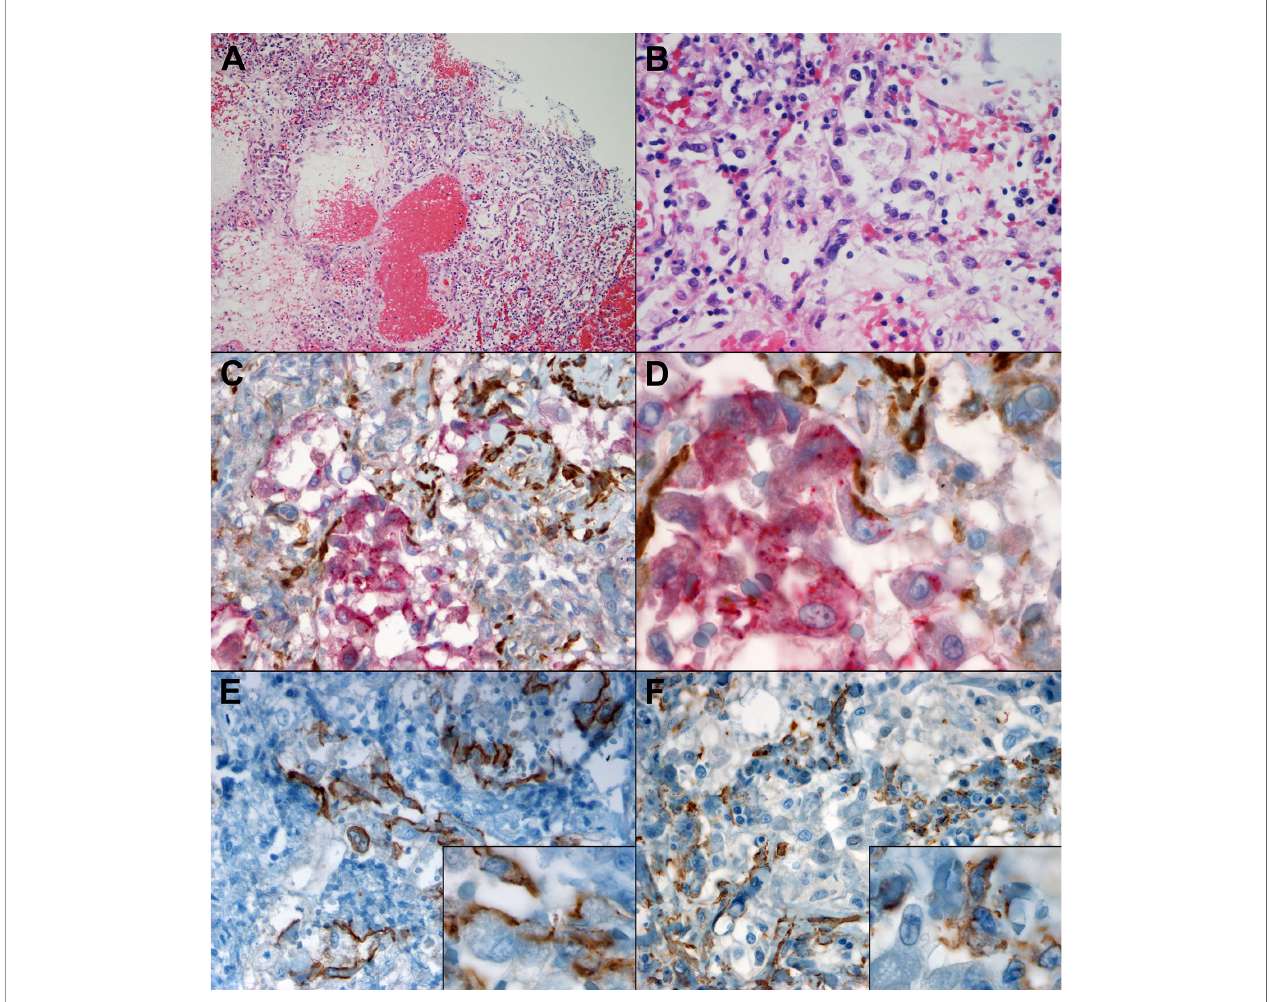
FIGURE 2 | Morphological and immunohistochemical clues of EMT in lung tissue of patients which died of COVID-19, with DAD in proliferative phase. (A) At low power, oedema, vascular congestion, hemorrhage, and in fl ammatory in fi ltrates are visible (H&E, 10x). (B) At higher magni fi cation, hyperplastic pneumocytes, a few granulocytes and fi brin deposition are evident (H&E, 40x). (C) Double IHC for an epithelial marker, CK7 (red) and a mesenchymal marker, a -SMA (brown) demonstrated co-expression in a subset of alveolar reactive pneumocytes (40x). (D) At higher magni fi cation, a gradient of CK7 loss can be observed within the epithelial cells, and a subset co-expresses CK7 (red) as well as a -SMA (brown) (100x). (E) IHC for E-cadherin highlights partial loss in epithelial cells, some of which demonstrate a spindle morphology (inset) (40x, inset 100x). (F) IHC for a -SMA demonstrated the presence within epithelioid cells (40x, inset